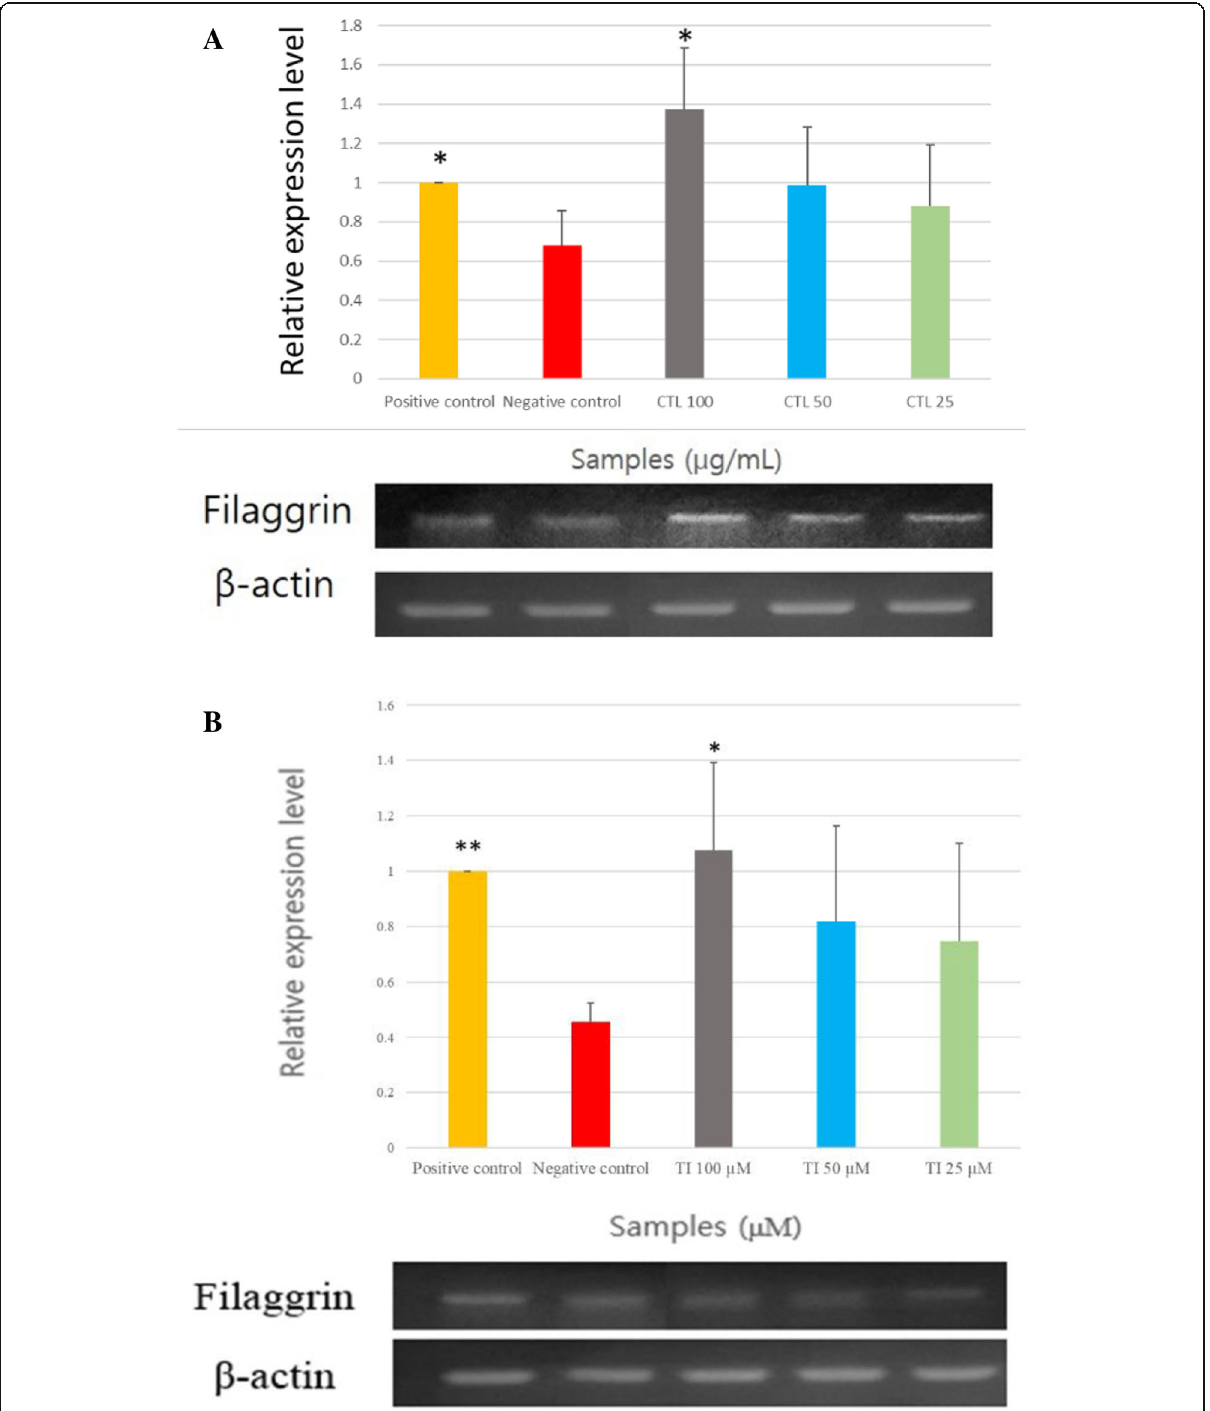
Fig. 1 Relative filaggrin mRNA expression level upon treatment with ( a ): Carpinus tschonoskii leaf (CTL) extract and ( b ): tellimagrandin I (TI) normalized to β -actin. The results are expressed as mean ± standard deviation (SD) of triplicate experiments. ( n = 3) **, p < 0.01; *, p < 0.05, comparison with negative control